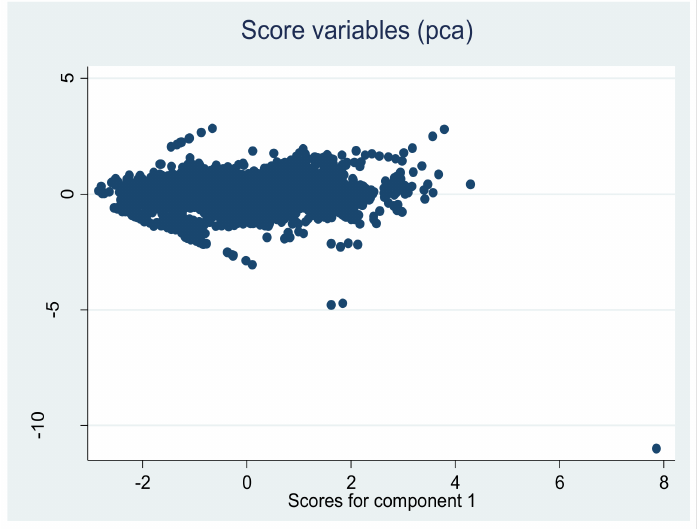
Figure 2. Scree plot and score variables of government spending and tax